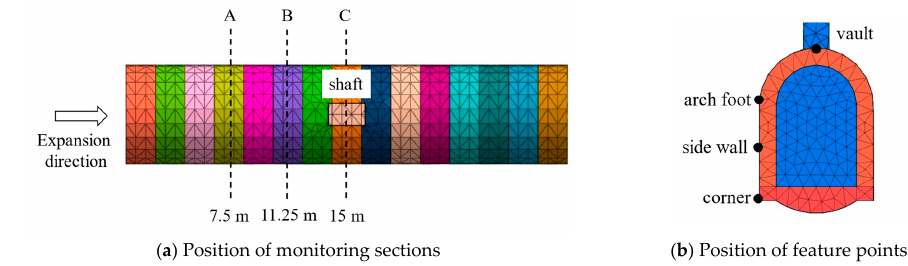
Figure 12. The layout of the monitoring sections and feature points.